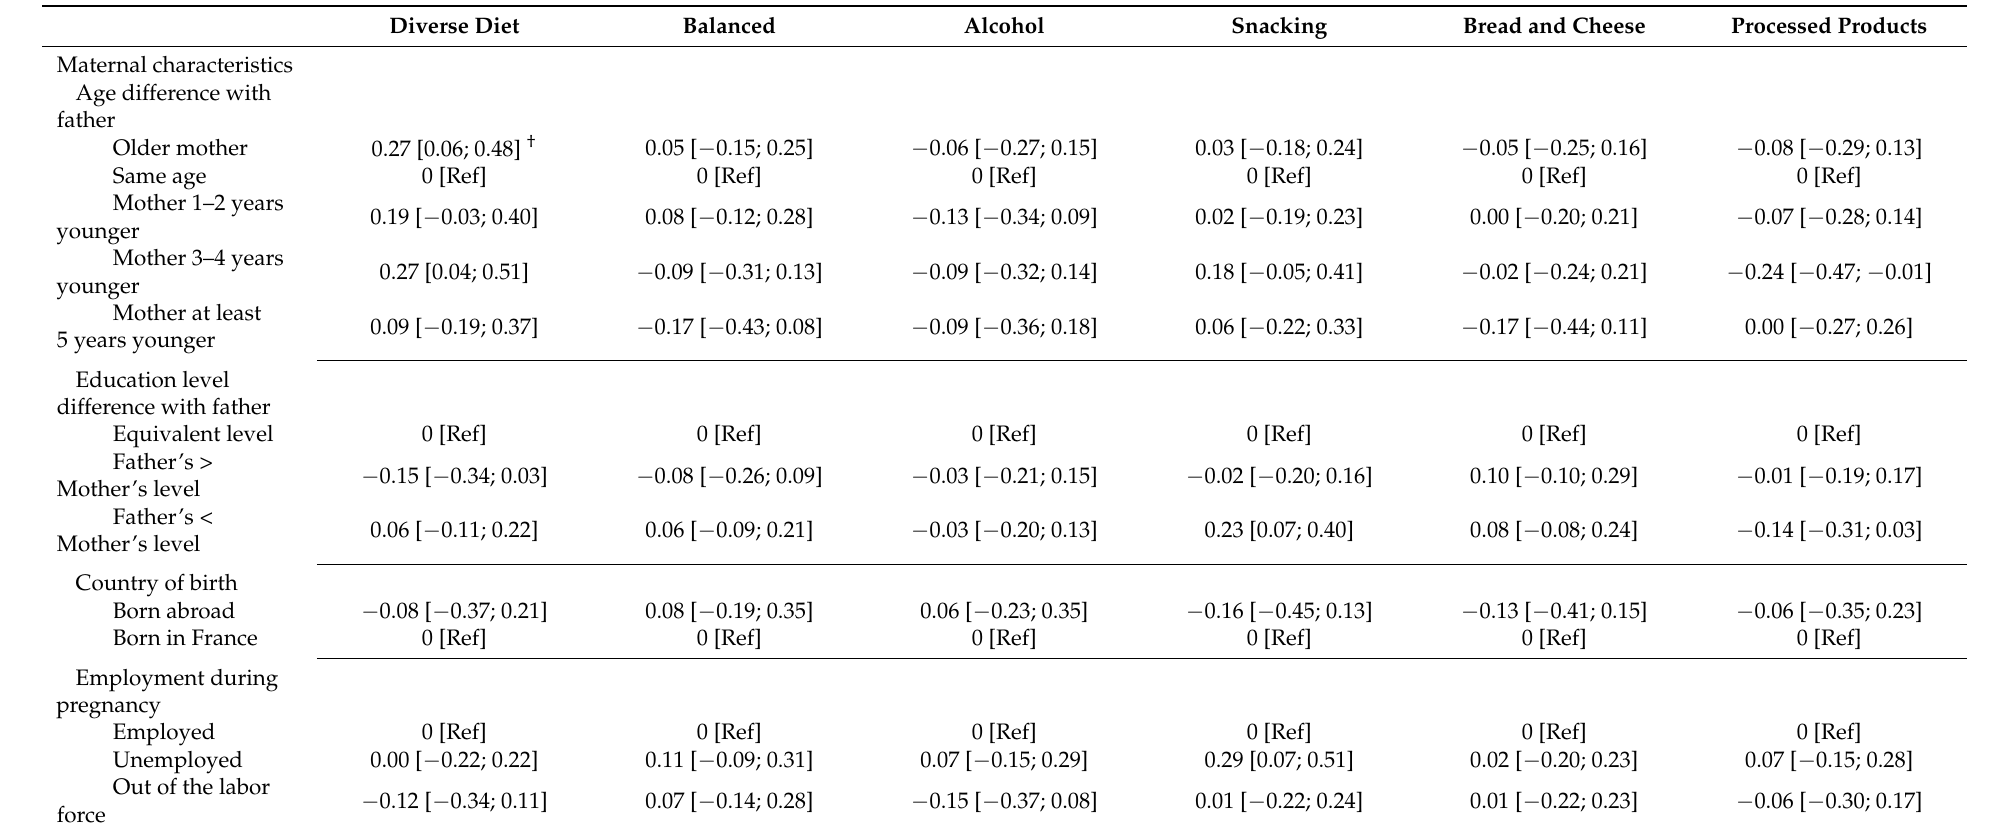
Table 3. Multivariable associations between maternal characteristics and paternal diet ( n = 998): the ELFE study, 2011. Diverse Diet Balanced Alcohol Snacking Bread and Cheese Processed